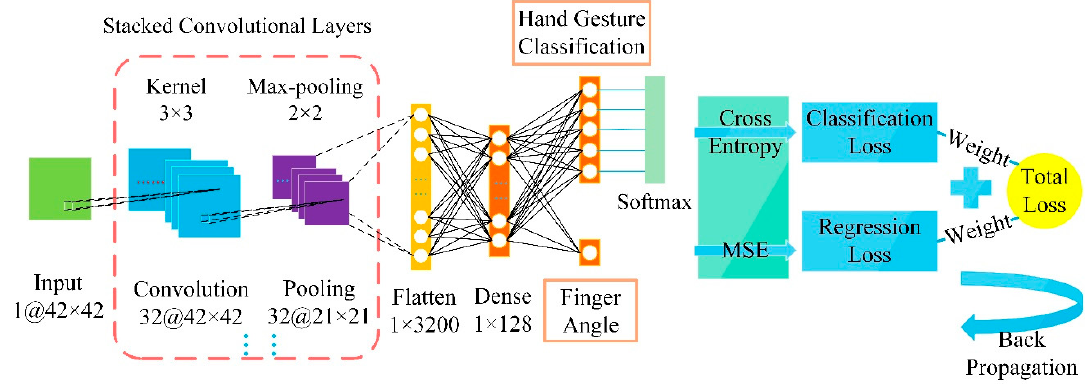
Figure 3. Dual-output CNN model structure diagram.